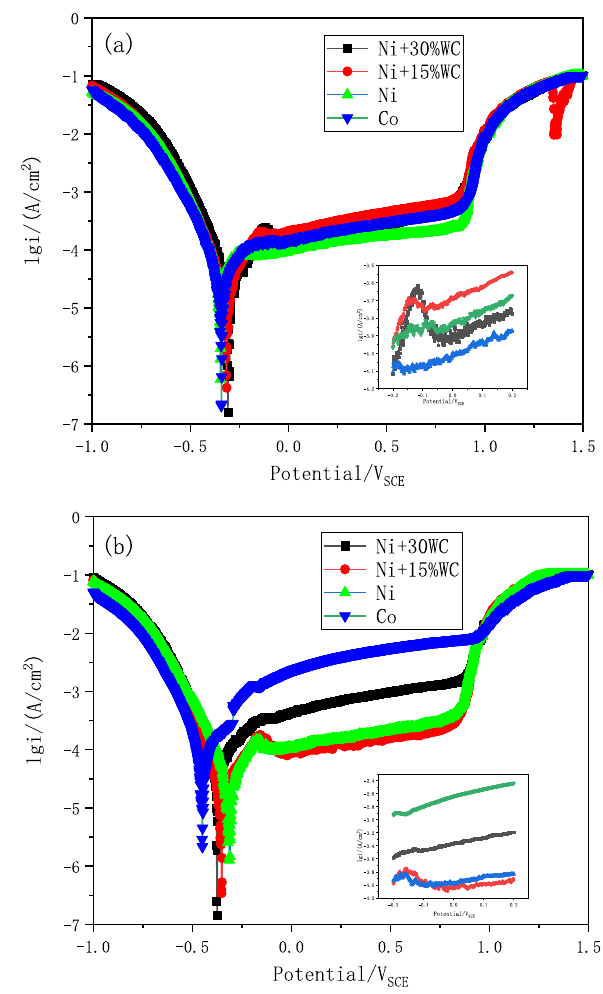
Figure 4: Potential polarization curve of di ff erent coatings in the